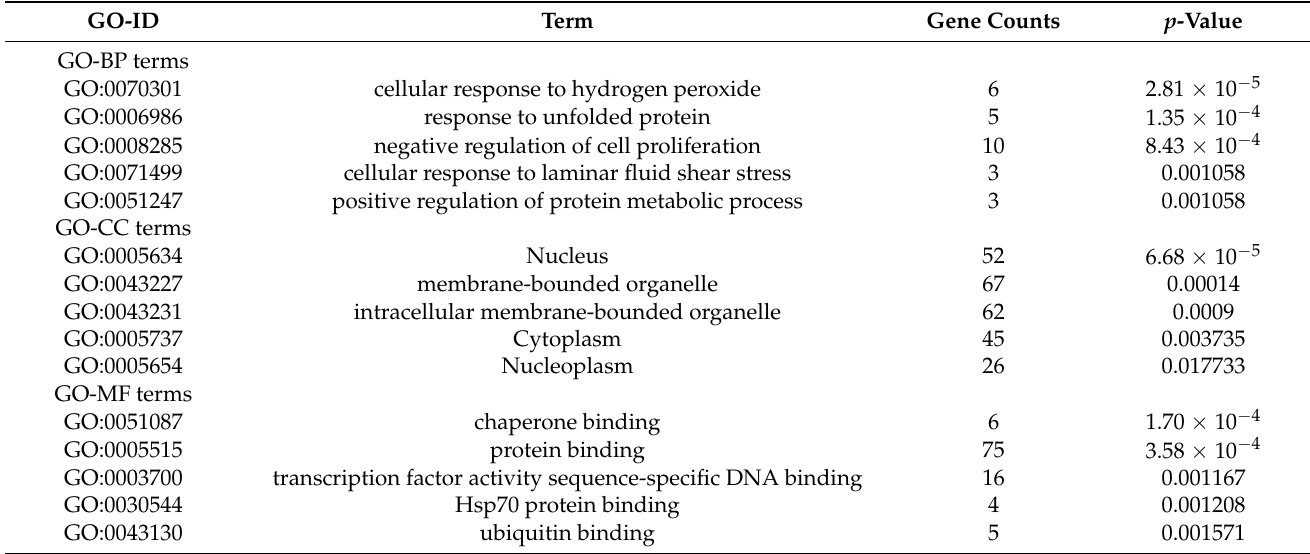
Table 1. Top 5 GO enrichment significance items in different functional groups.